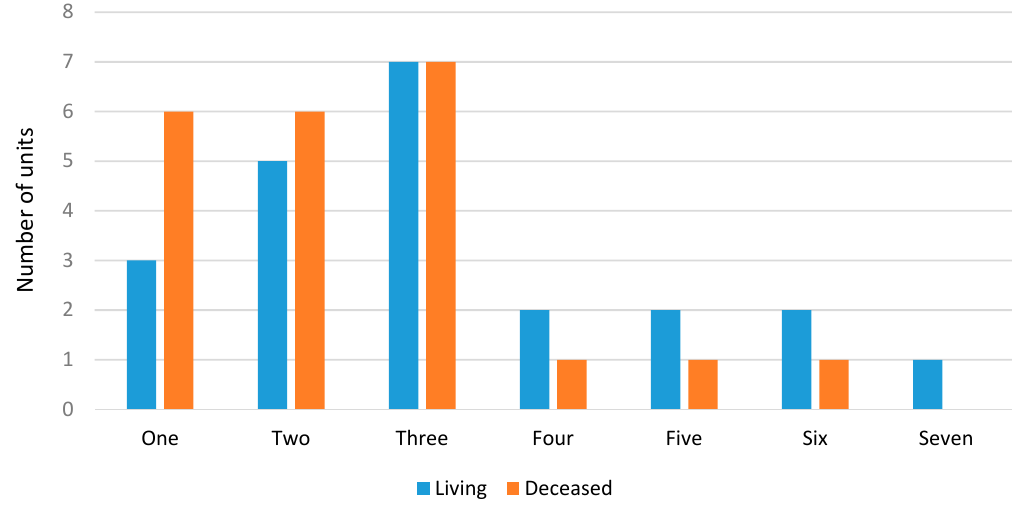
Figure 4. Number of methods used by each unit in living and deceased subjects.